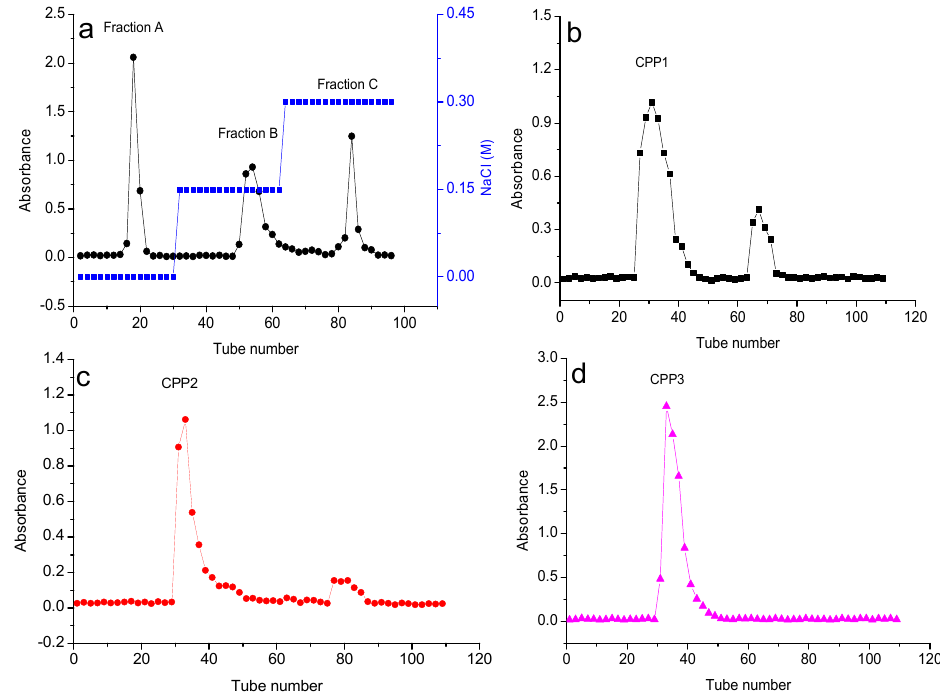
Figure 1. Elution curves of the CCPPs from the DEAE-52 column with NaCl solution (0, 0.15, and 0.3 M) ( a ); Elution curves of fractions A, B, and C from the Sephadex G-100 gel column with ultrapure water ( b – d , respectively).